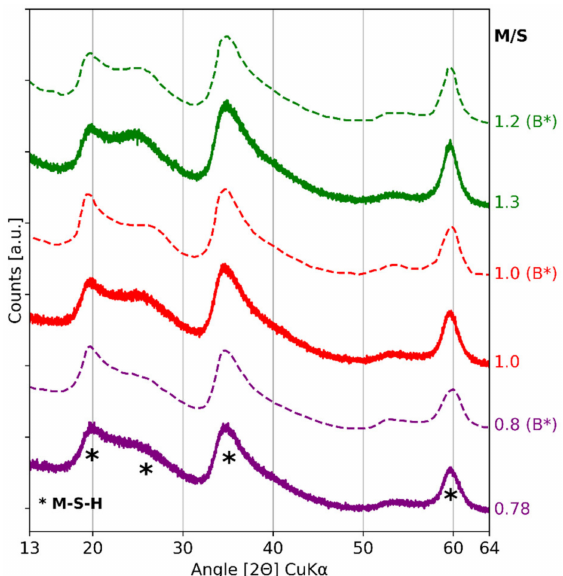
Figure 9. X-ray diffractograms of three M-S-H pastes with colloidal silica after 4.5 months of a 50 ◦ C curing and three M-S-H powders synthetized by Bernard et al. [43] (dashed lines, noted B*). Manual mixing was used for pastes M/S = 0.78 and M/S = 1.3; mechanical mixing was used for M/S =